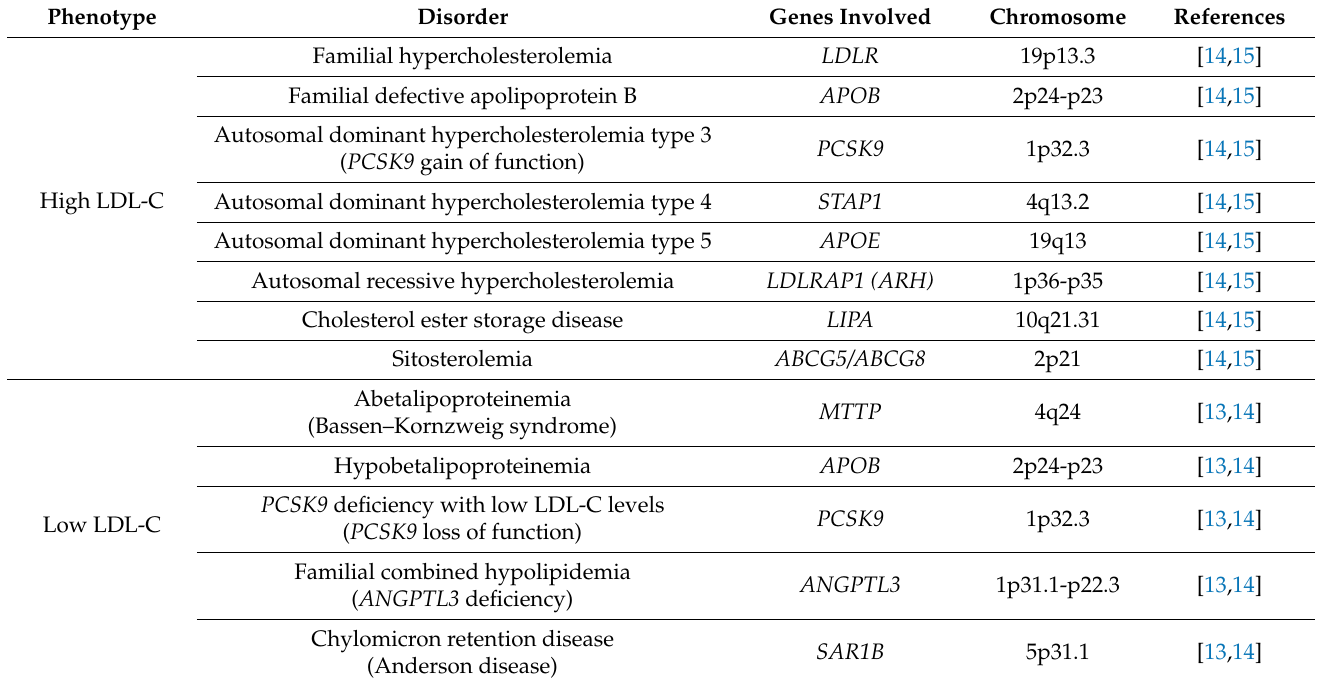
Table 3. Monogenic dyslipidemias and